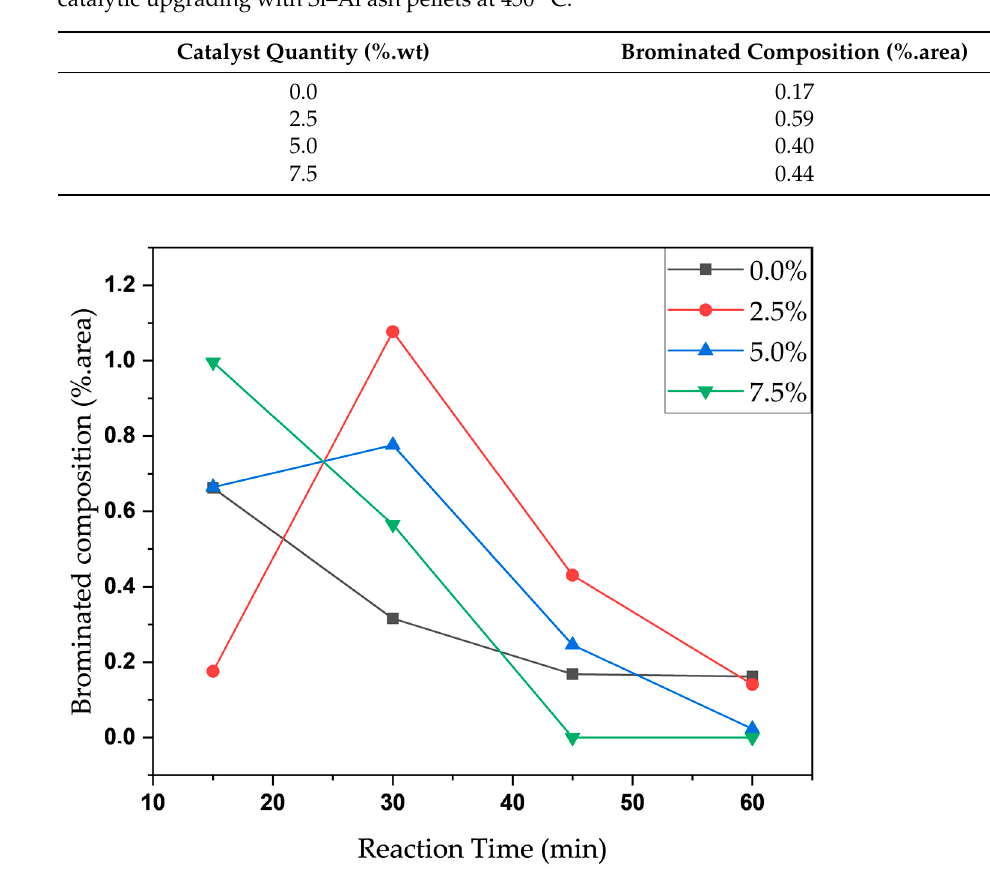
Figure 16. Effect of reaction time on brominated compound composition.